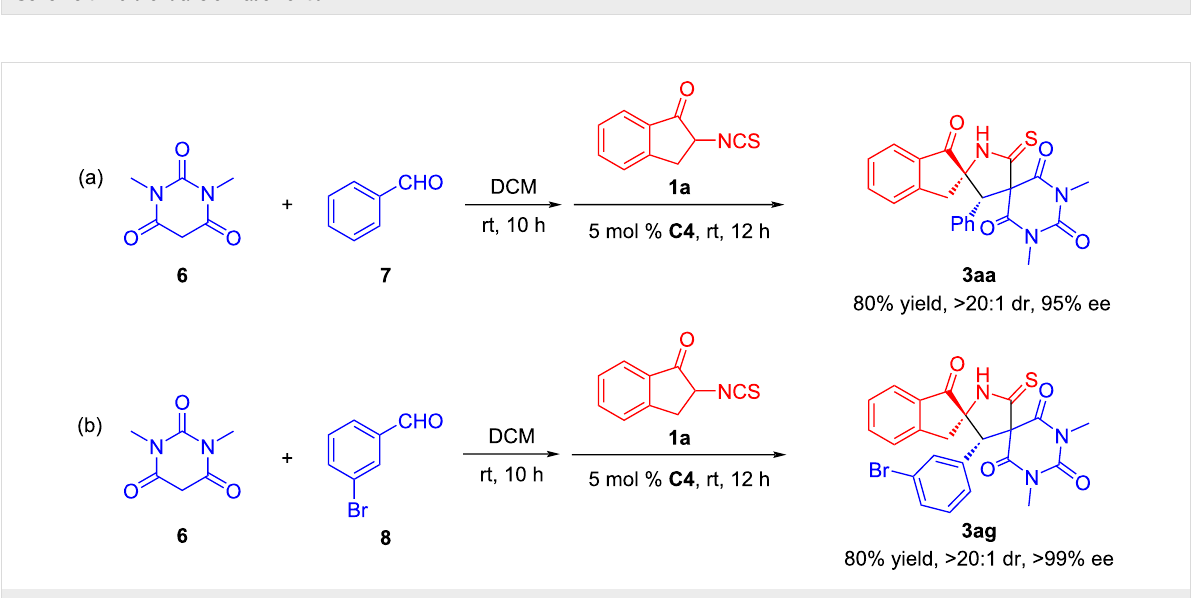
Scheme 6: One-pot three-component